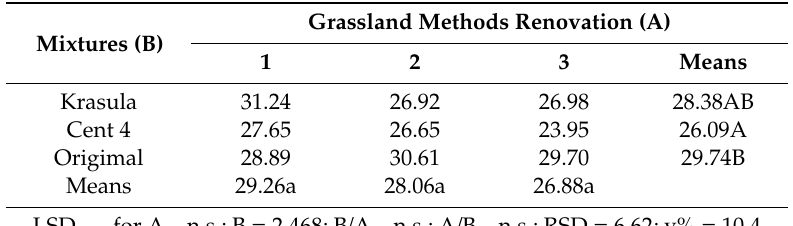
Table 1. Influence of the usage of the renovation of the grassland and species composition of legume–grass mixtures on the total dry matter yield of 3 years (t · ha − 1